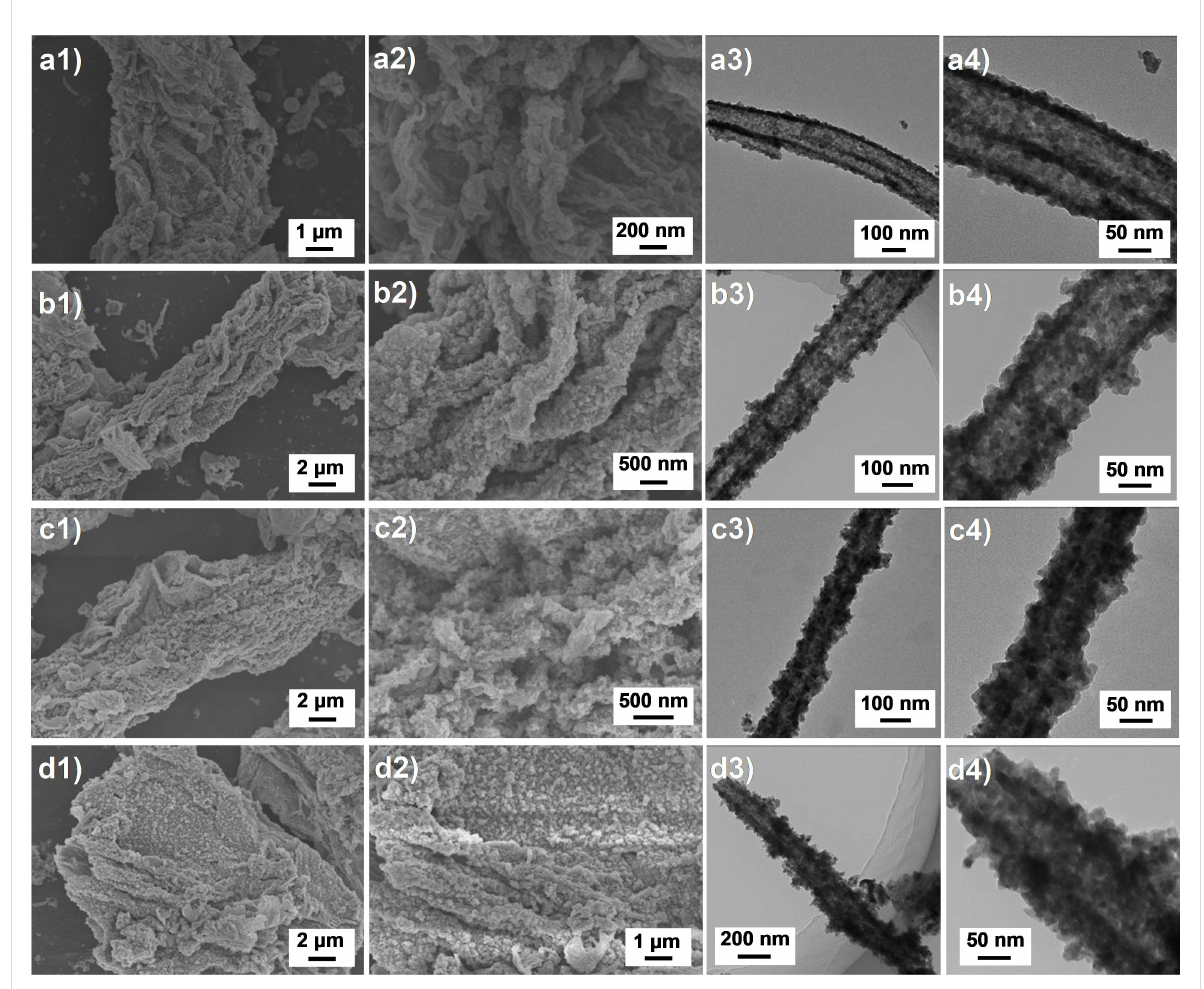
Figure 3: Electron micrographs of the hierarchical (a1 − a4) 30% − Bi 2 WO 6 /TiO 2 -NT, (b1 − b4) 50% − Bi 2 WO 6 /TiO 2 -NT, (c1 − c4) 70% − Bi 2 WO 6 /TiO 2 -NT, and (d1 − d4) 90% − Bi 2 WO 6 /TiO 2 -NT nanocomposites. The first two columns represent FE-SEM images of the nanocomposites showing the three- dimensional network structures. The last two columns exhibit TEM images of an individual composite nanotube which was separated from the corre- sponding